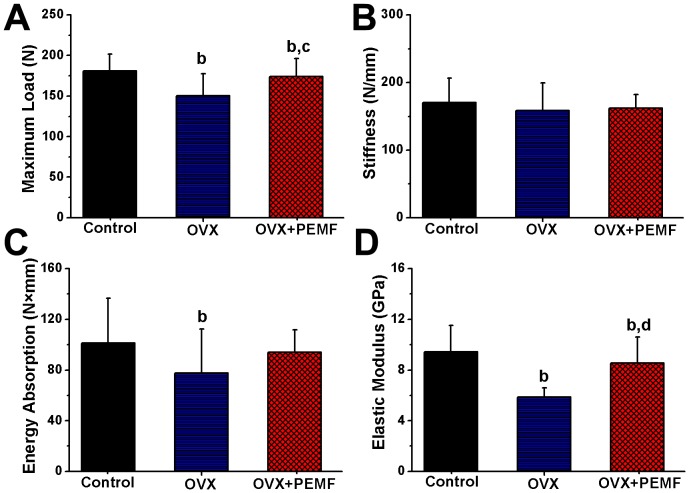
Effects of 10-week PEMF exposure on femoral biomechanical parameters (A) maximum load (B) stiffness (C) energy absorption (D) elastic modulus in OVX rats.Control, sham-operated control group; OVX, ovariectomy group; OVX+PEMF, ovariectomy with PEMF exposure group. Values are all expressed as mean ± S.D. (n = 10). bSignificant difference from the Control group with P<0.01; bcSignificant difference from the Control group with P<0.01 and OVX group with P<0.05; bdSignificant difference from the Control group and OVX group with P<0.01.